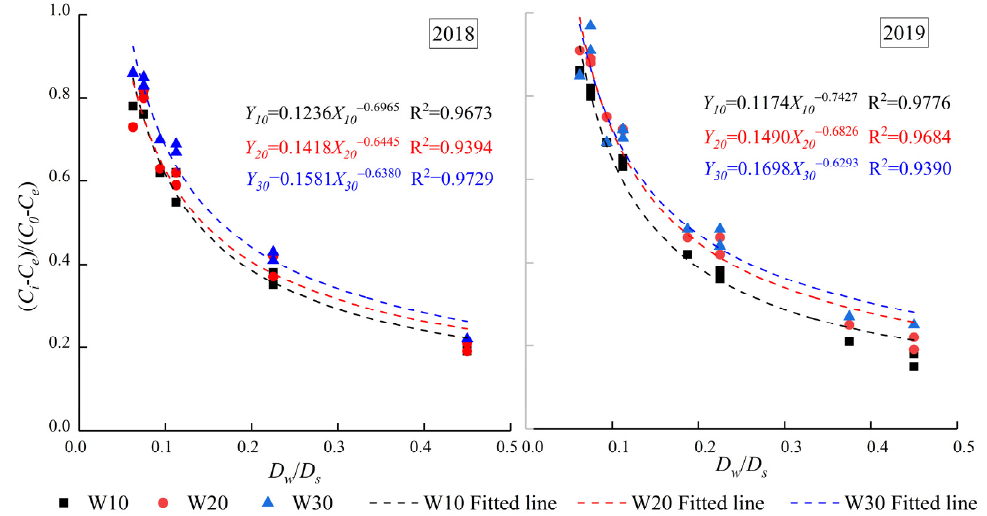
Figure 6. Soil salinity leaching curve. W10, W20, and W30 mean the drain spacing of 10, 20, and 30 m, respectively. CK means no drainage.